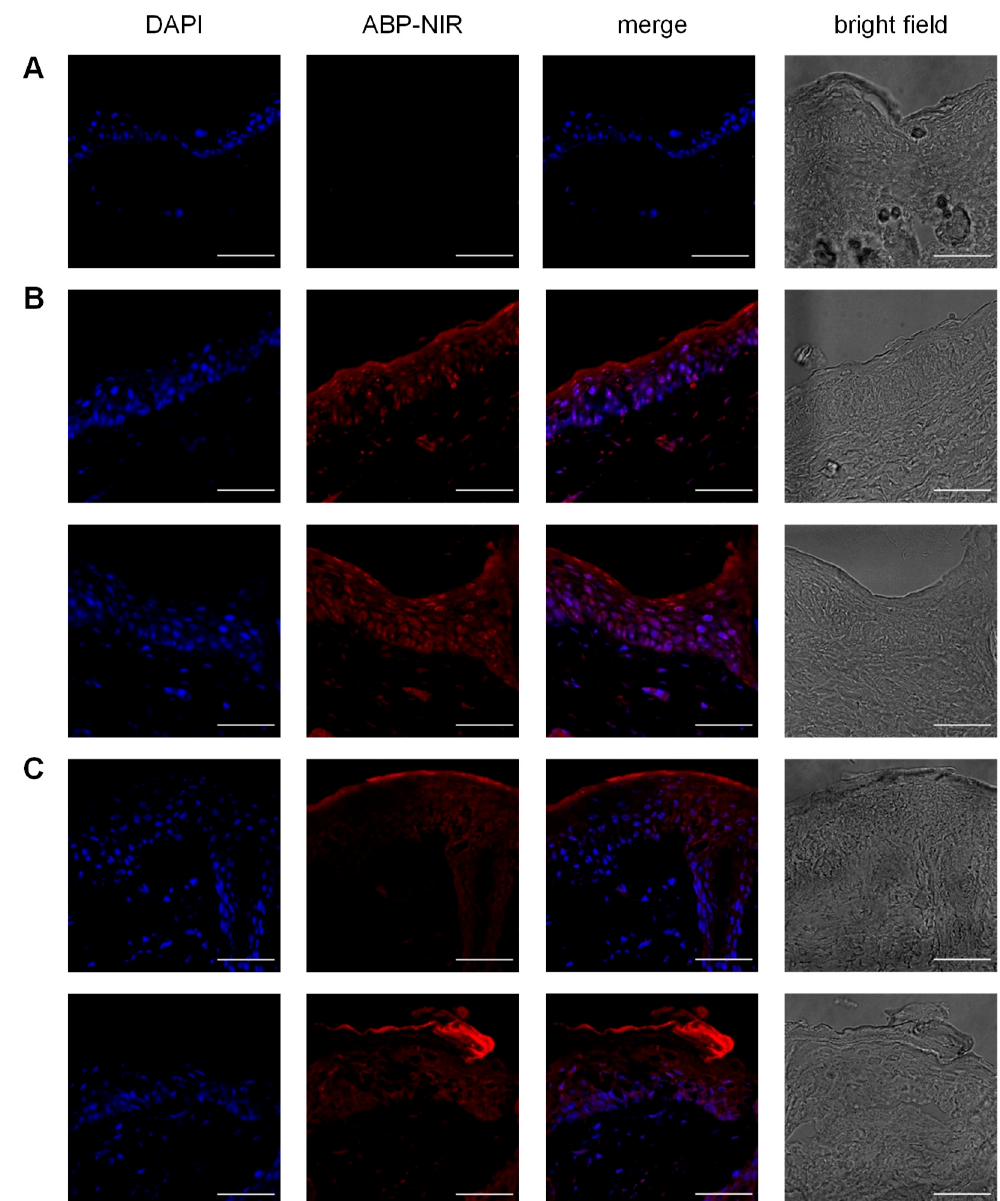
Figure 3. Penetration of the IMQ-induced psoriatic skin by the near infra-red (NIR) ABP-NIR dendrimer, a fluorescent analogue of the ABP dendrimer. First column shows the nuclear 4’,6-diamidino-2-phenylindole (DAPI) staining, second column shows the near infra-red fluorescence of the ABP-NIR dendrimer, third column shows the merge of the first two columns, and last column shows bright field imaging of ( A ) skin incubated with phosphate-buffered saline (PBS; control), and ( B ) day 5 and ( C ) day 7 psoriatic skins incubated with the ABP-NIR dendrimer (two mice each). Scale bars represent 50 µm.